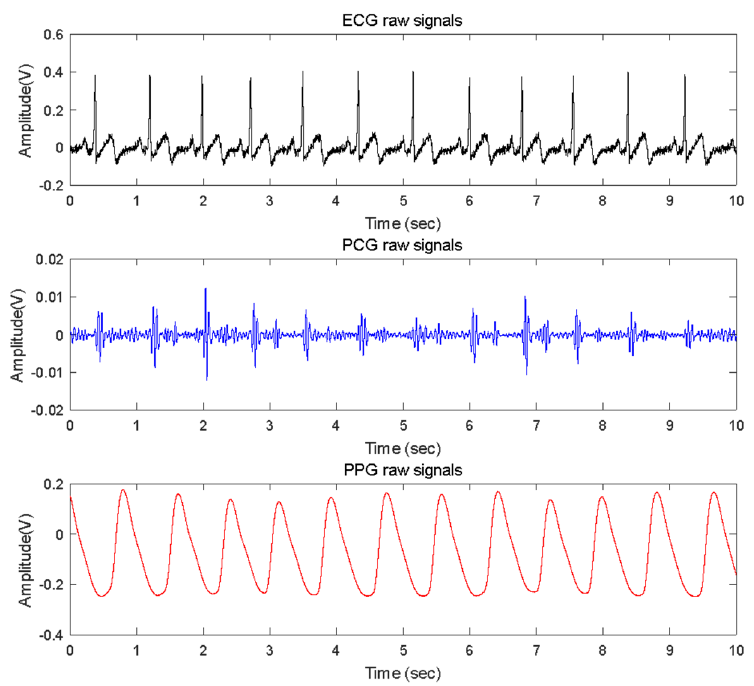
Figure 3. Example of plots of simultaneously recorded ECG, PCG, and PPG signals. The sample data in this plot is for Subject ID XY008, included in the Keimyung University-Heart Sounds Database (KMU-HSDB). The partially extracted data for the graph is from 20,000 to 40,999 of the original data based on the sample number, and the data length is 10 s (sampling rate is 2000 Hz). The top black, middle blue, and bottom red plots represent the raw data of ECG, PCG, and PPG, respectively. The x-axis represents time, measured in seconds; the y-axis is the amplitude of each signal, and the unit is volts (V). Table 1. Description of subject participating in this